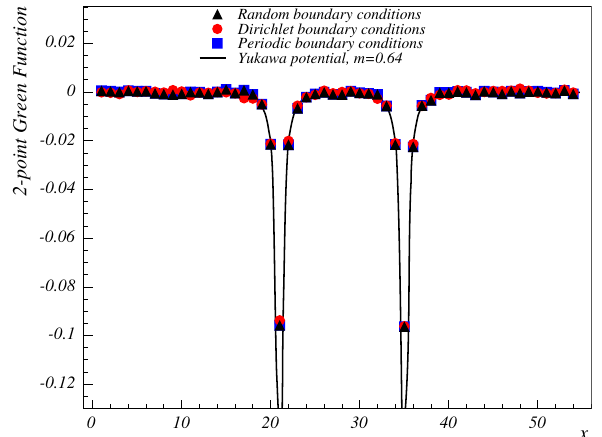
Fig. 2 Potential G 2 p for the g 2 φ 4 theory, plotted as a function of dis- tance. The simulations used a lattice size N = 55, a coupling g 2 = 0 . 5, a decorrelation coefficient (see Sect. B.1) N cor = 20 and N s = 5 × 10 4 configurations. The results are independent of the choice of boundary conditions. They are well fit by two Yukawa potentials centered on each twosourcesat d = ± 7fromthelatticecenterandwithamassparameter m eff = 0 . 64 ( contin u o u s line )